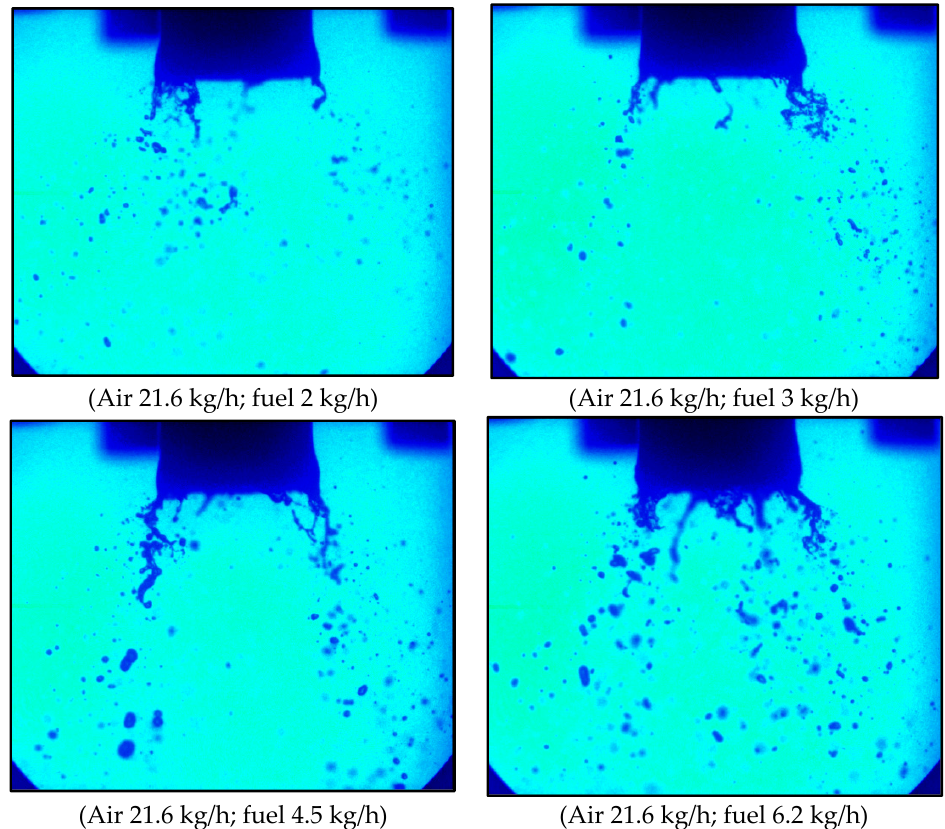
Figure 21. The influence of fuel mass rate on the liquid film breakup process (Case B) (Transient results).